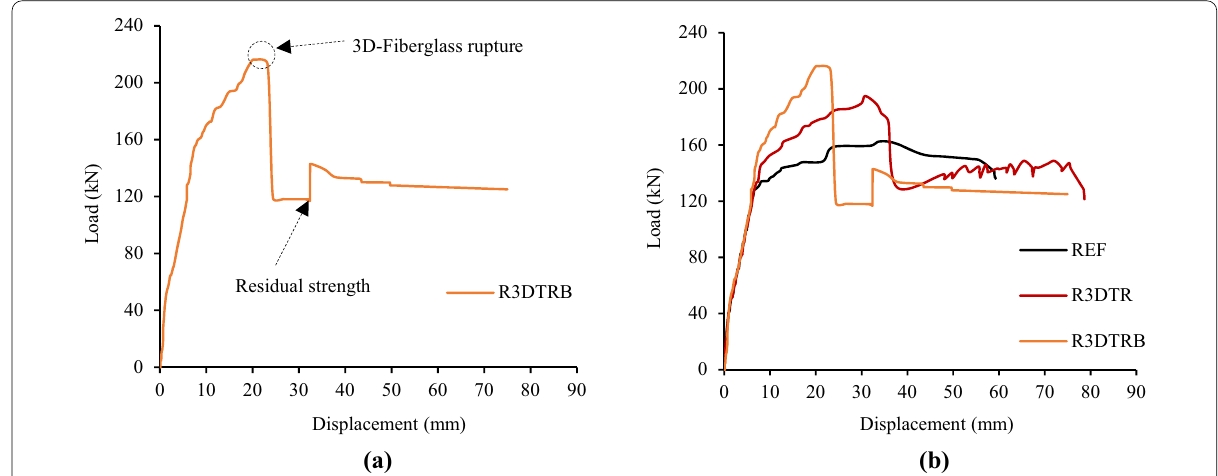
Fig. 17 Load–displacement curves of tested beams: a R3DTRB specimen, and b comparison of REF, R3DTR and R3DTRB specimens.